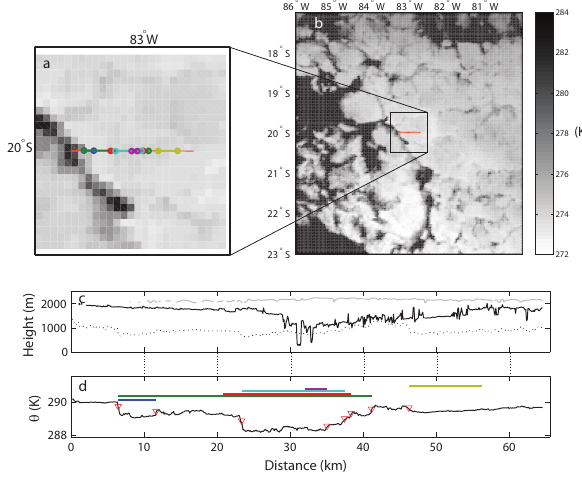
Fig. 3. The top panels show the GOES-10 satellite imagery from 11µm channel in a 1 ◦ (a) and 6 ◦ square box (b) centered on the flight leg (orange) taken during the flight leg (23 October 2008 at 10:28UTC). (c) Corresponds to Fig. 1a, where cloud top height (gray), cloud base height (solid black), and LCL (dotted) are shown. The θ time series in (d) shows the location and size of cold pools de- tected by the algorithm described in the text. Each colored segment over the θ time series represents an individual cold pool.